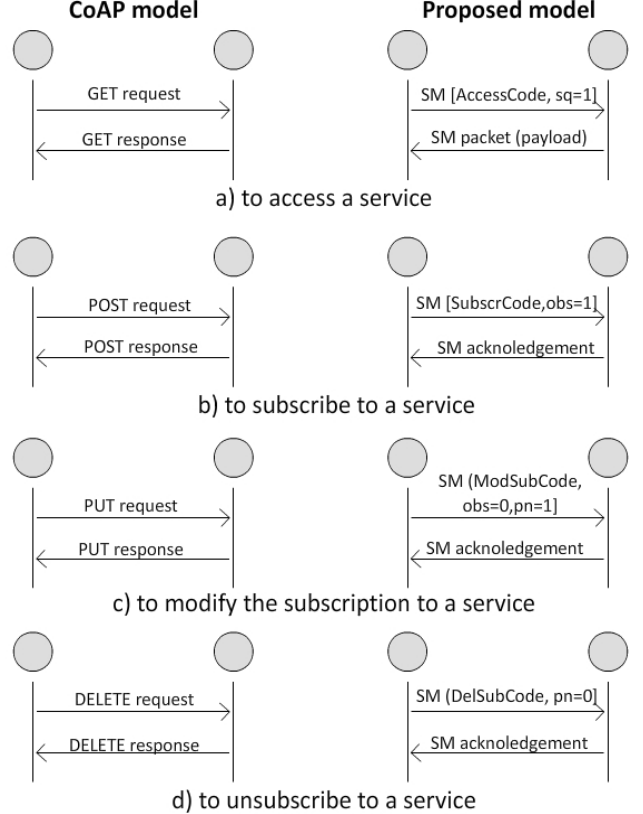
Figure 4. Matching among exchange